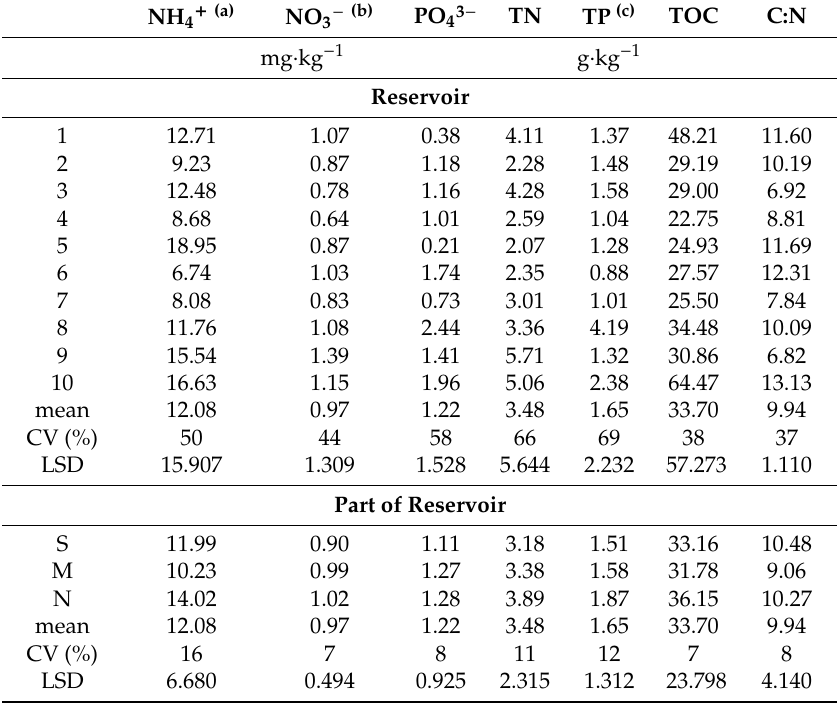
Table 1. Mean values of phosphorus and nitrogen compounds and organic carbon in sediments of reservoirs 1–10 and their parts S, M and N.